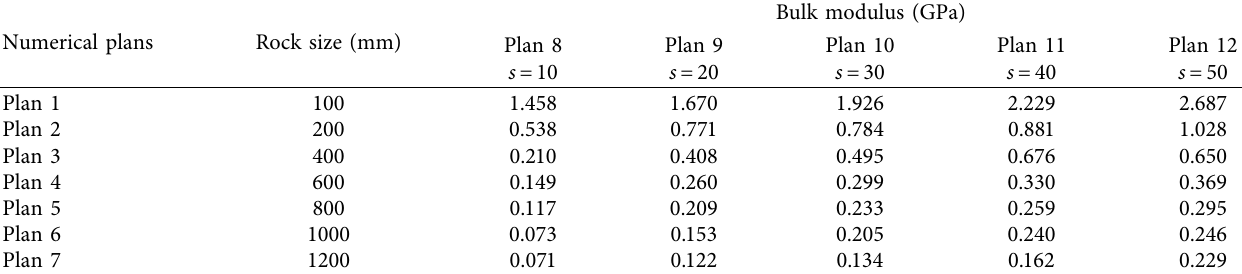
Table 4: Values of bulk